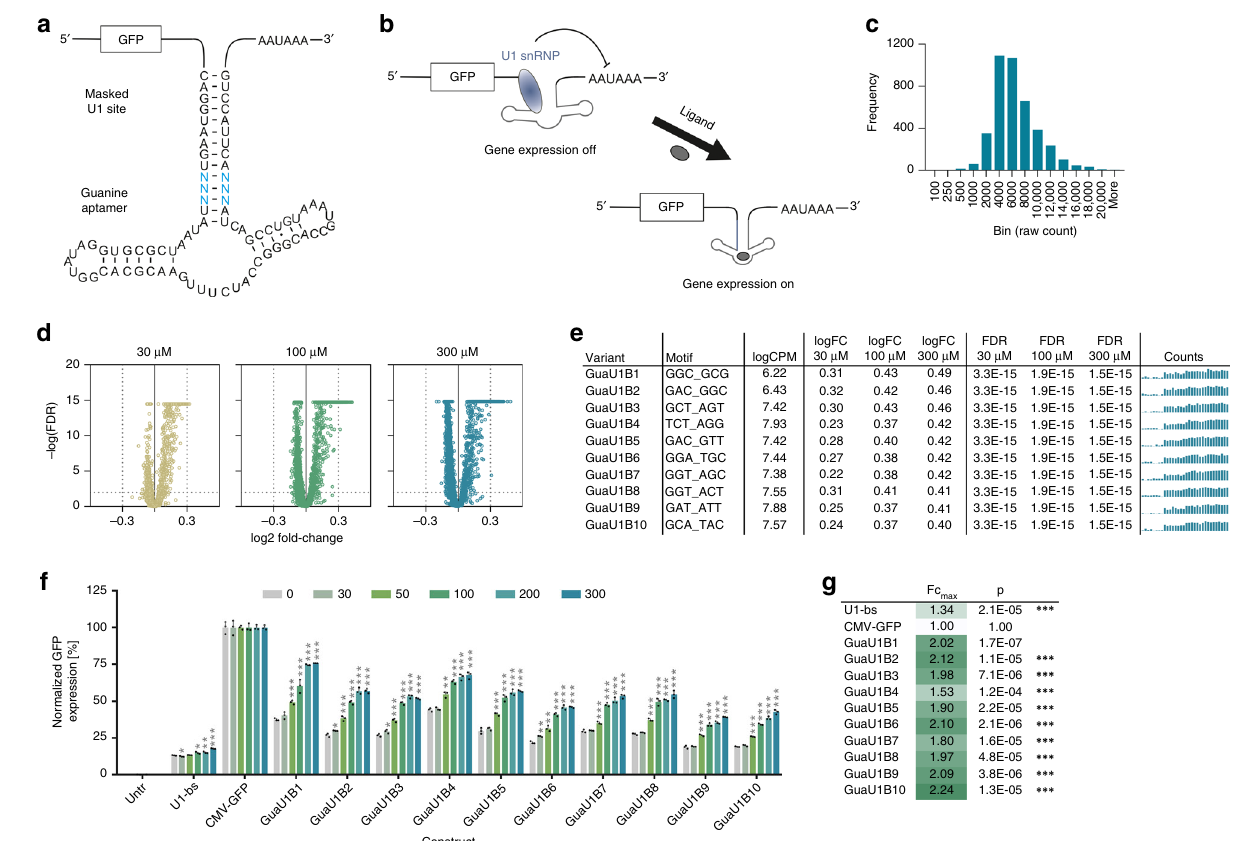
Fig. 6 Identi fi cation of Gua-responsive riboswitches based on a U1-snRNP-dependent mode of action. a Secondary structure of the Gua-U1-snRNP riboswitch library design. The U1-snRNP binding site (CAGGUAAGU) is included into a prolonged stem P1 of the guanine aptamer. Blue nucleotides indicate the randomized motif. b Mode of action of U1-snRNP-dependent riboswitches. In the ligand-unbound conformation, the U1-snRNP binding site is available, allowing for U1-snRNP binding and interference with the polyadenylation process. Upon ligand binding, the aptamer stem is stabilized and the U1- snRNP binding site is masked, enabling polyadenylation and subsequent gene expression. c Guanine riboswitch construct frequency analysis of the original library. d Volcano plots showing the signi fi cance (FDR) of changes in riboswitch abundance as a function of the change in expression (log 2 fold change). e Selected hits from the Gua-U1-snRNP riboswitch library screen, randomized sequence, mean counts per million (CPM), fold change (FC) and false- discovery rate (FDR) at 30, 100, and 300 µ M guanine, respectively. The bar plots show the raw counts under untreated, 30, 100, and 300 µ M µ M Gua- stimulated conditions (four groups from left to right, n = 8 replicates each). f Functional hit validation in HEK-293 cells at increasing guanine doses [ µ M] ( n = 3 replicates, mean ± s.d.); U1-bs: construct harboring the freely accessible U1-snRNP binding site. g Maximal fold changes and p -values measured upon stimulation vs. 0 µ M guanine for all tested constructs. * p < 0.05, ** p < 0.01, *** p < 0.001 (unpaired T -Test, two-tailed). Source data are provided as a Source Data fi